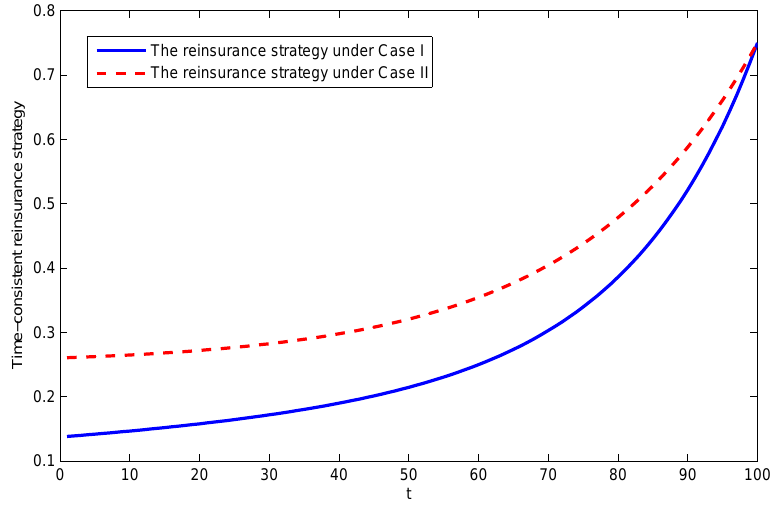
Figure 4. Time-consistent reinsurance strategy under the expected value principle ( α = 0.6 and T =